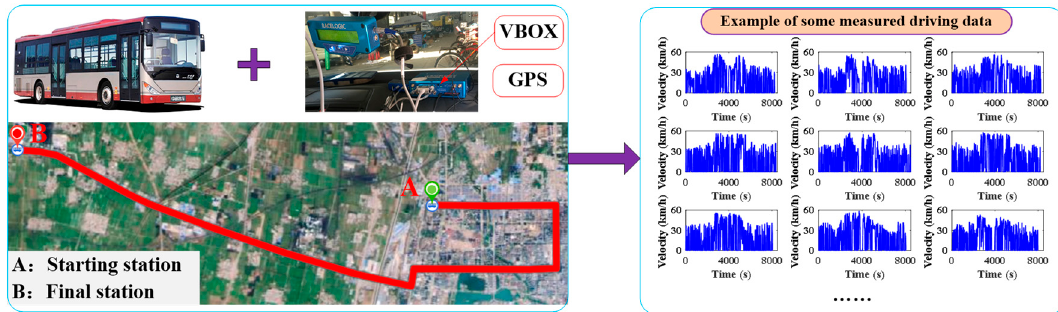
Figure 2. Measurement of the historical driving data.